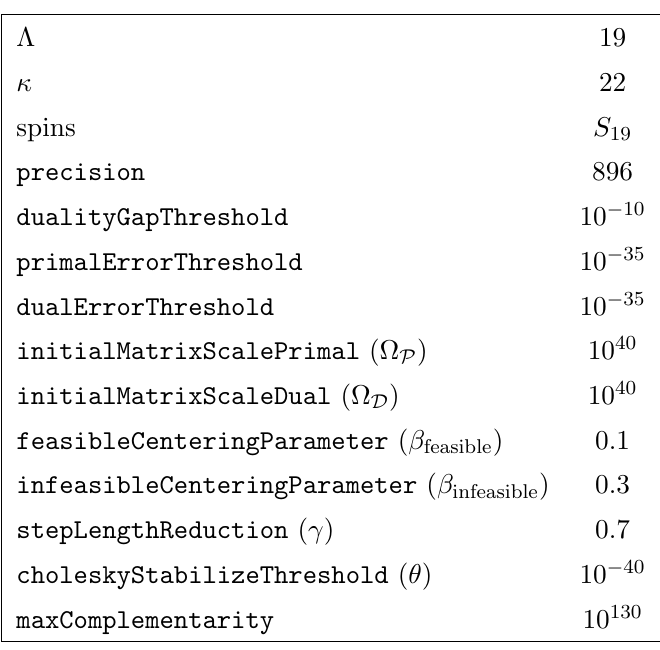
Table 4 . Parameters for the computations in this work. Only SDPB parameters that a(cid:11)ect the numerics (as opposed to parameters like maxThreads and maxRuntime ) are included. The set of spins used is S 19 = f 0 ; 1 ; 2 ; : : : ; 25 g [ f 29 ; 30 ; 33 ; 34 ; 37 ; 38 ; 41 ; 42 ; 45 ; 46 ; 49 ; 50 g . Open